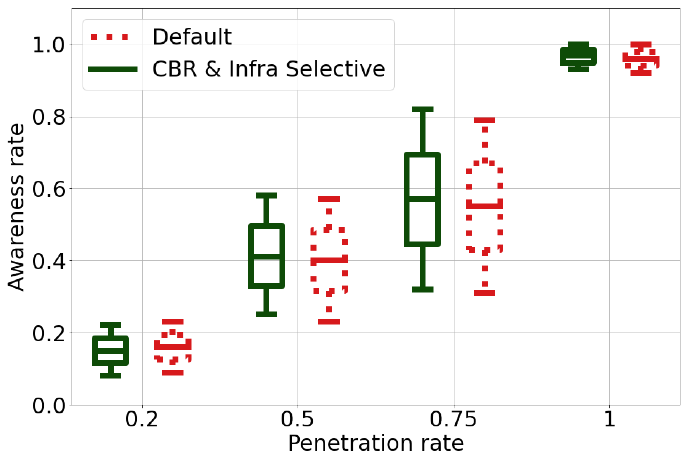
Figure 8. Awareness rate function of penetration rate for Default, CBR & Infra selective